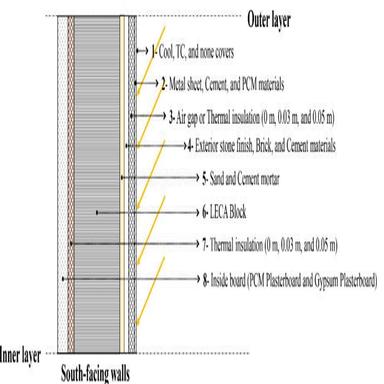
Proposed advanced materials and facade layers.